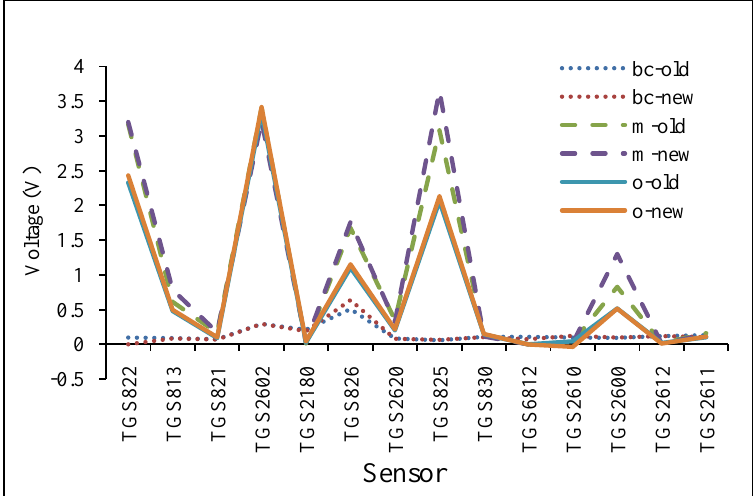
Figure 8. The Vr obtained with old and new sensor